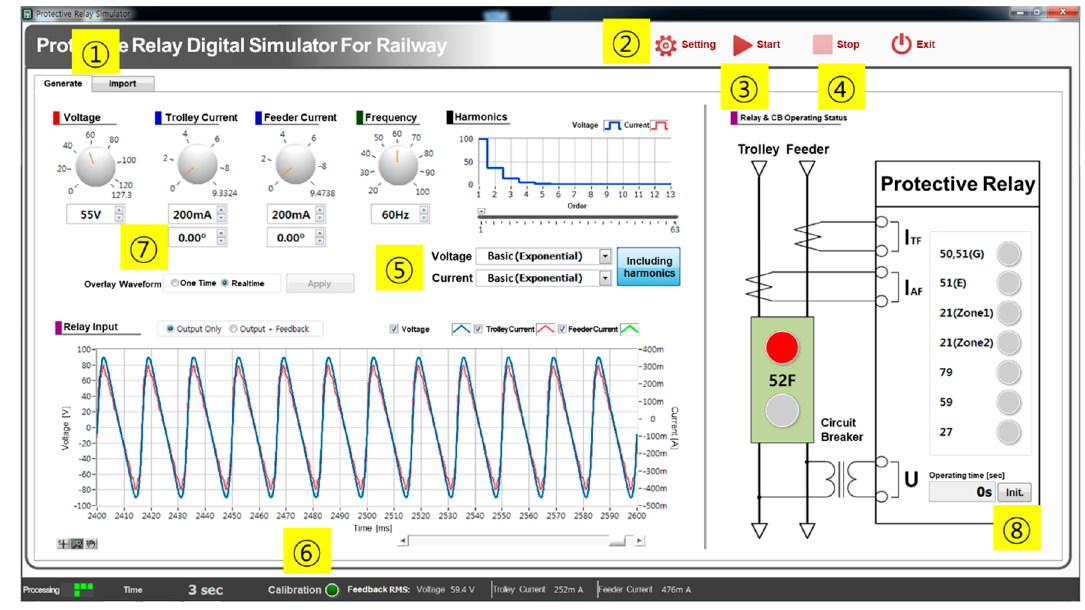
Figure 6. Main interface of the PREDIS-R. Table 1. Main interface configuration and